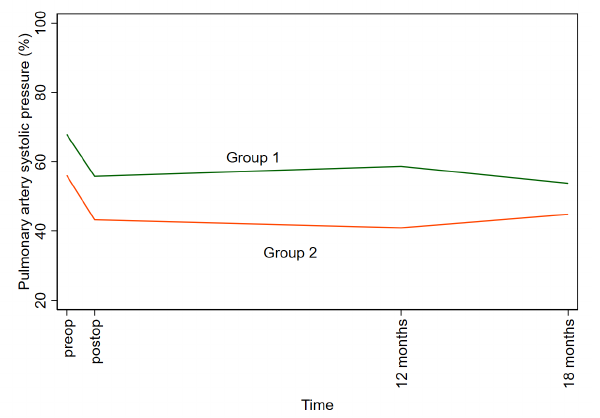
Supplementary Fig. 2 - Changes in pulmonary artery pressure in both groups.